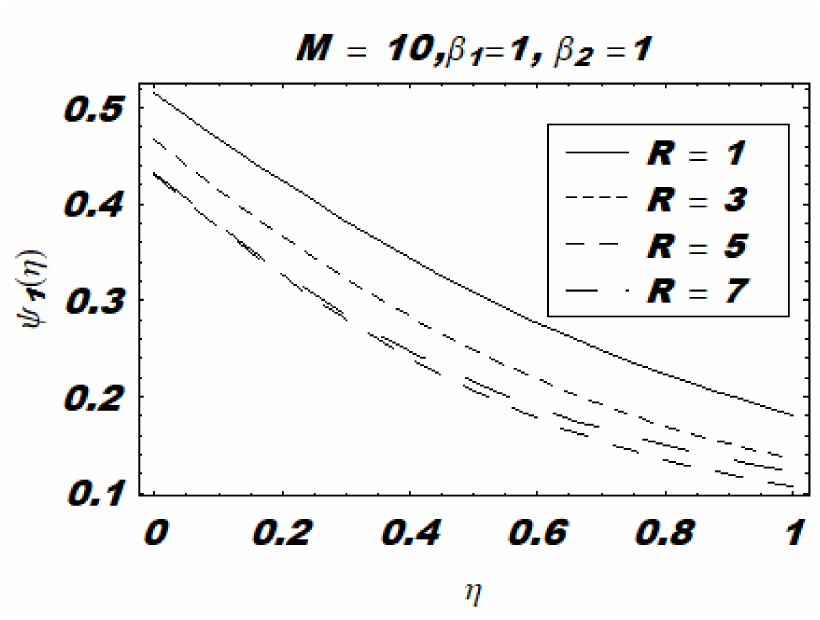
Figure 28. Similarity function ψ 1 for the circular